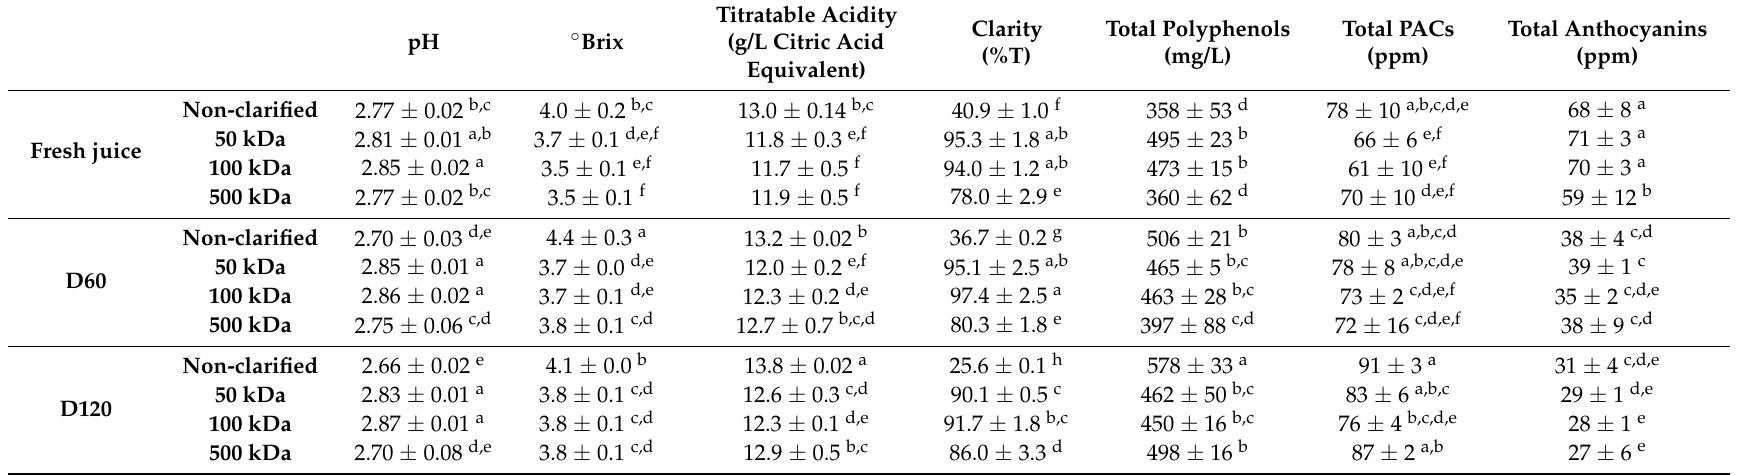
Data with different letters (a–g) in the same column are significantly different (LSD, p < 0.05). A two-way analysis of variance (ANOVA) was performed at a 95% confidence level. Fisher’s protected least significant difference (LSD) was used to compare membrane cut-offs and juice depectinization